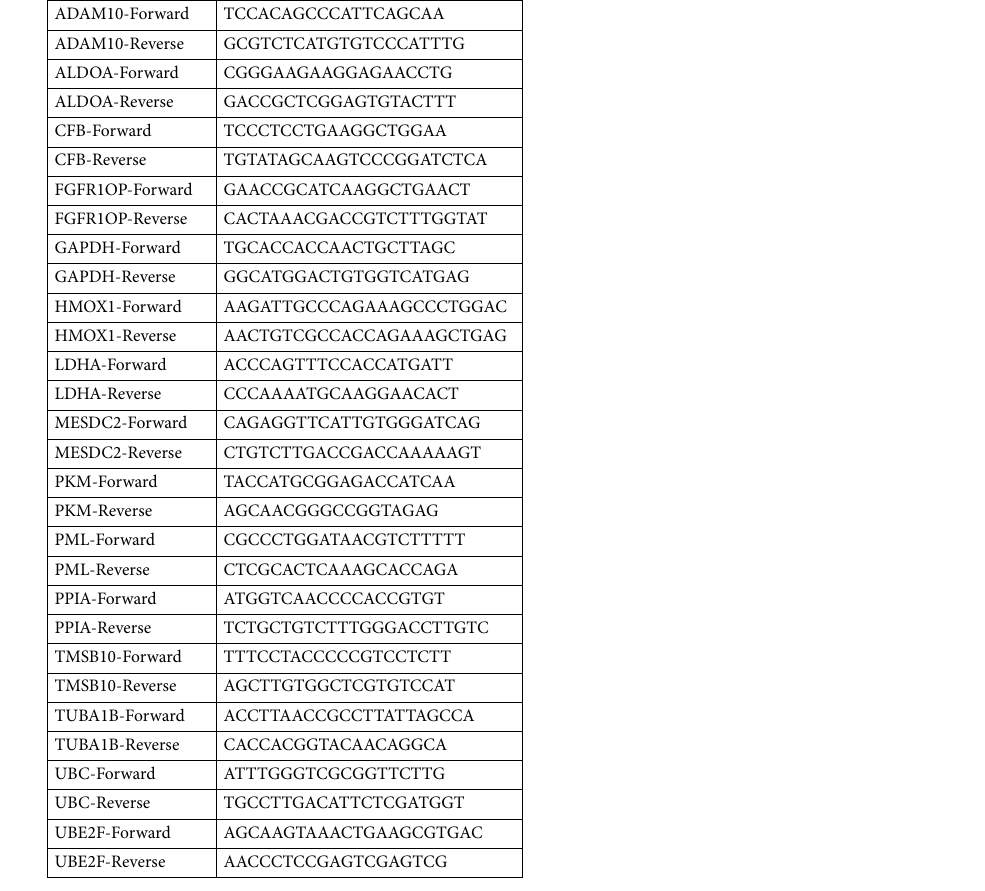
Table 7. The primer sequences of 15